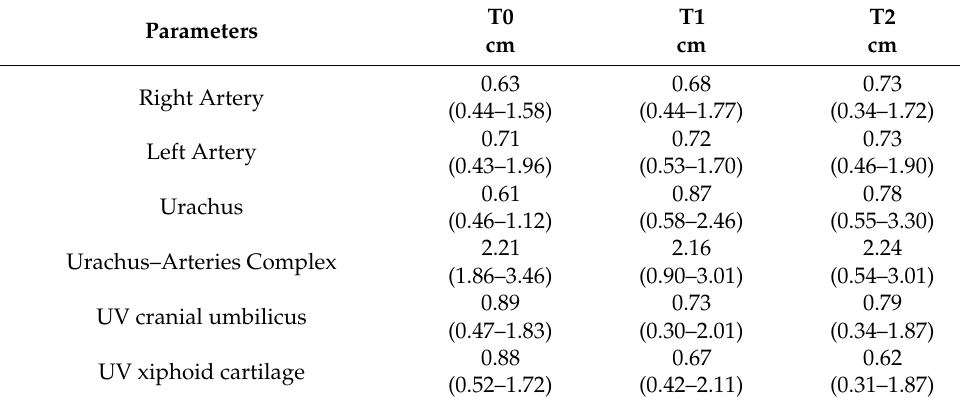
T0 T1 T2 cm cm cm 0.63